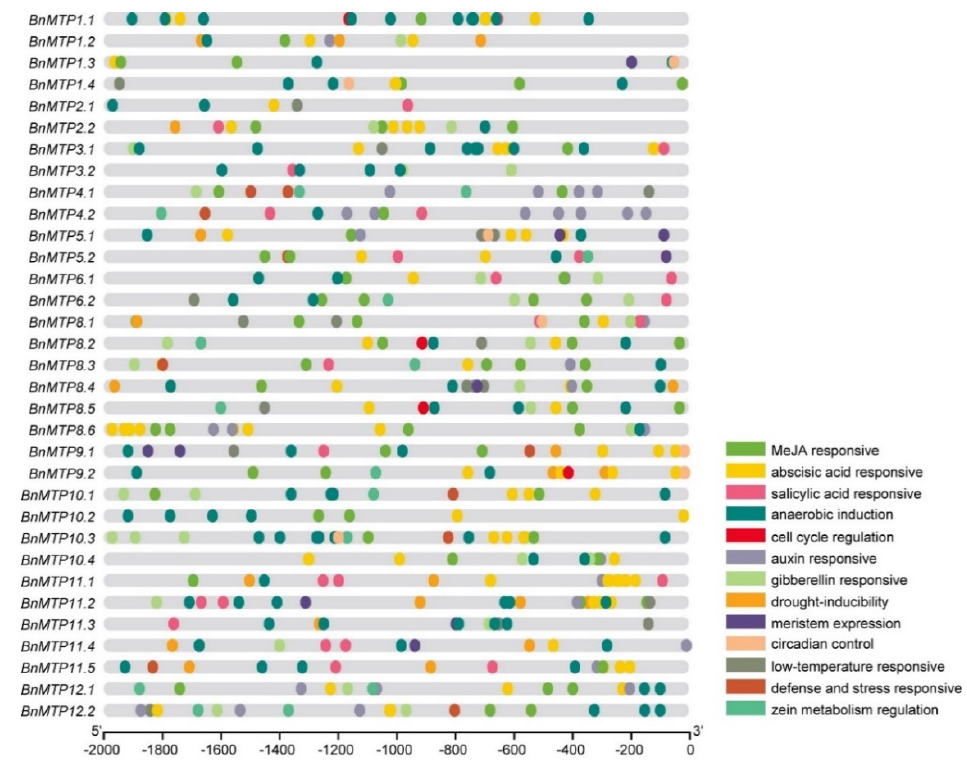
Figure 8. Cis- acting regulatory elements in the promoter region of BnMTP genes. The presence of different cis- acting elements was determined by the PlantCARE software. Different colored ovals represent different type of cis -elements.